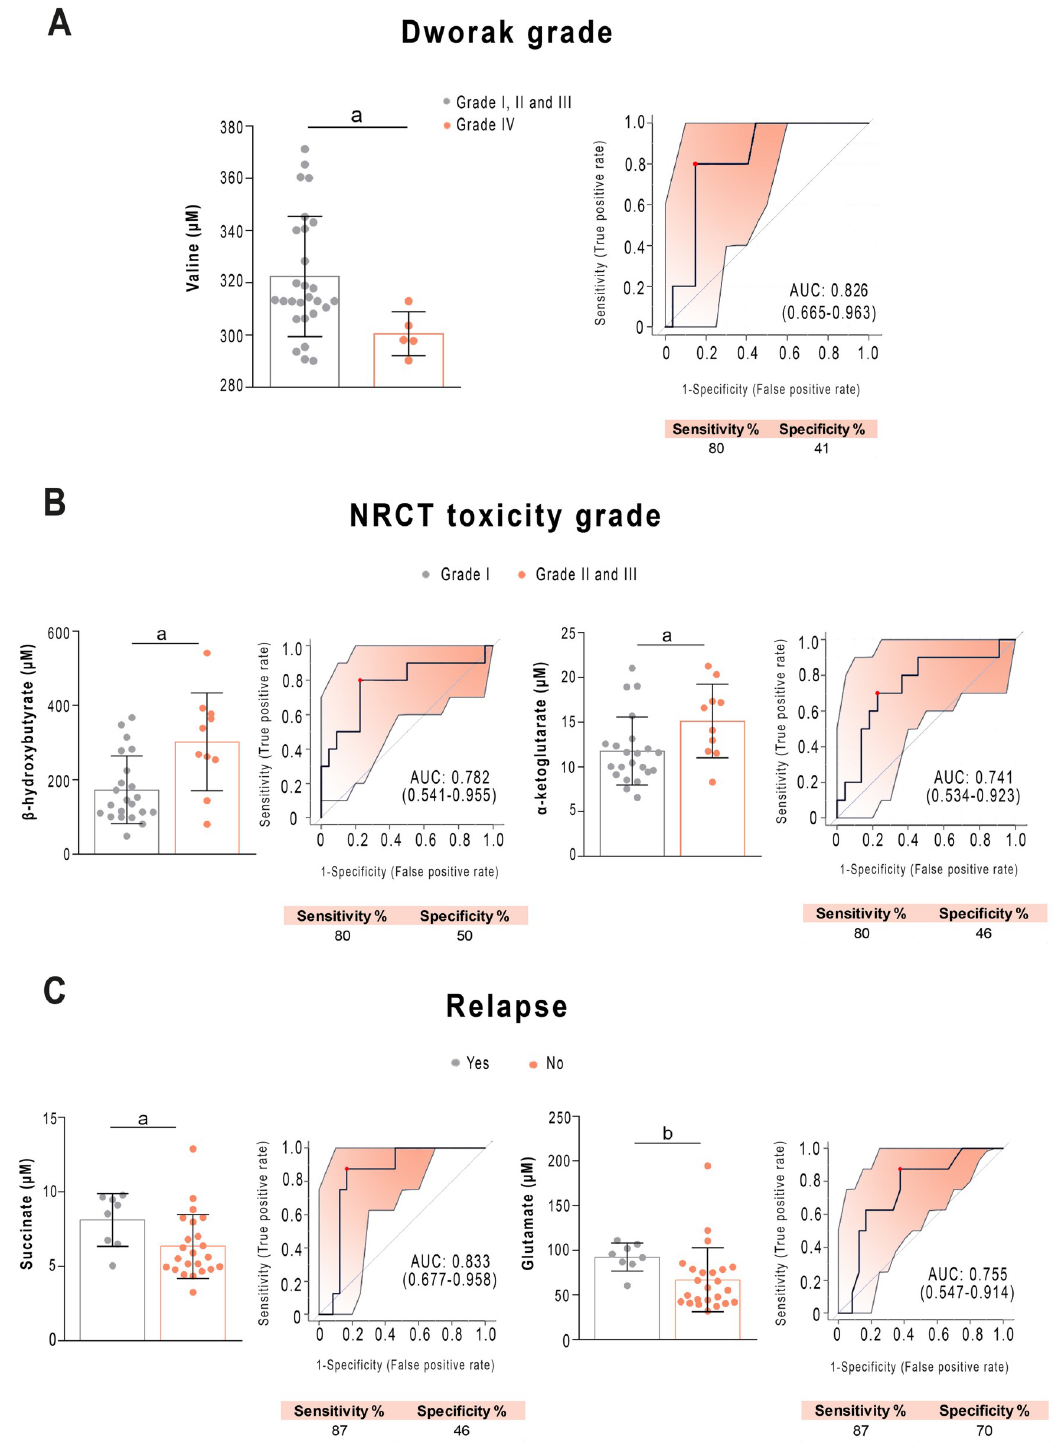
Fig 7. Selected metabolites predicting the prognosis of patients with rectal cancer before treatment. Receiver operating characteristics curve-based model evaluation showing that valine was related to Dworak grade (A), β -hydroxybutyrate, α - ketoglutarate were related to neoadjuvant radiochemotherapy (NRCT) toxicity grade (B), add succinate and glutamate were related to tumour relapse (C). Sensitivity and specificity are shown as percentages. AUC: Area under the curve. a = p < 0.05; b = p < 0.01.